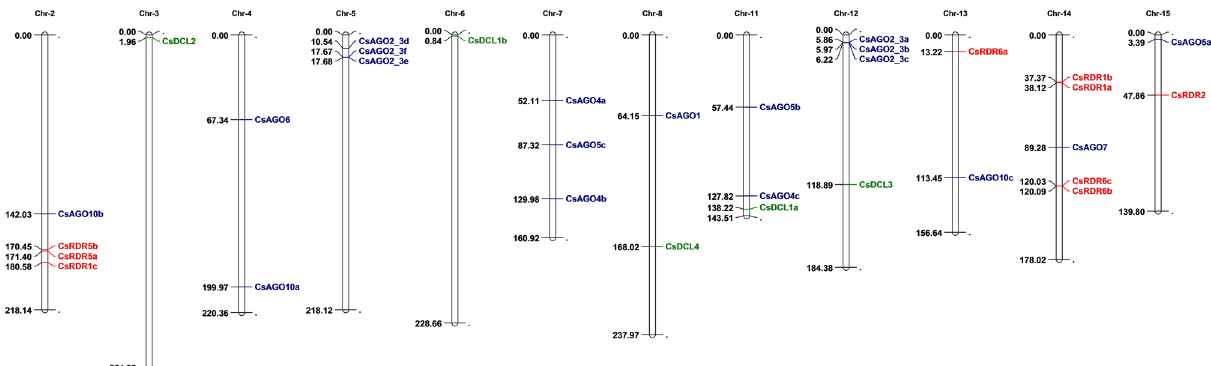
Figure 7. The distribution of AGO, DCL and RDR genes on pseudo-chromosomes of C. sinensis . Chromosome numbers have been indicated on the top of each chromosome. The position of each gene on the respective chromosome has been depicted in terms of kilobase-pairs by numbers beside each